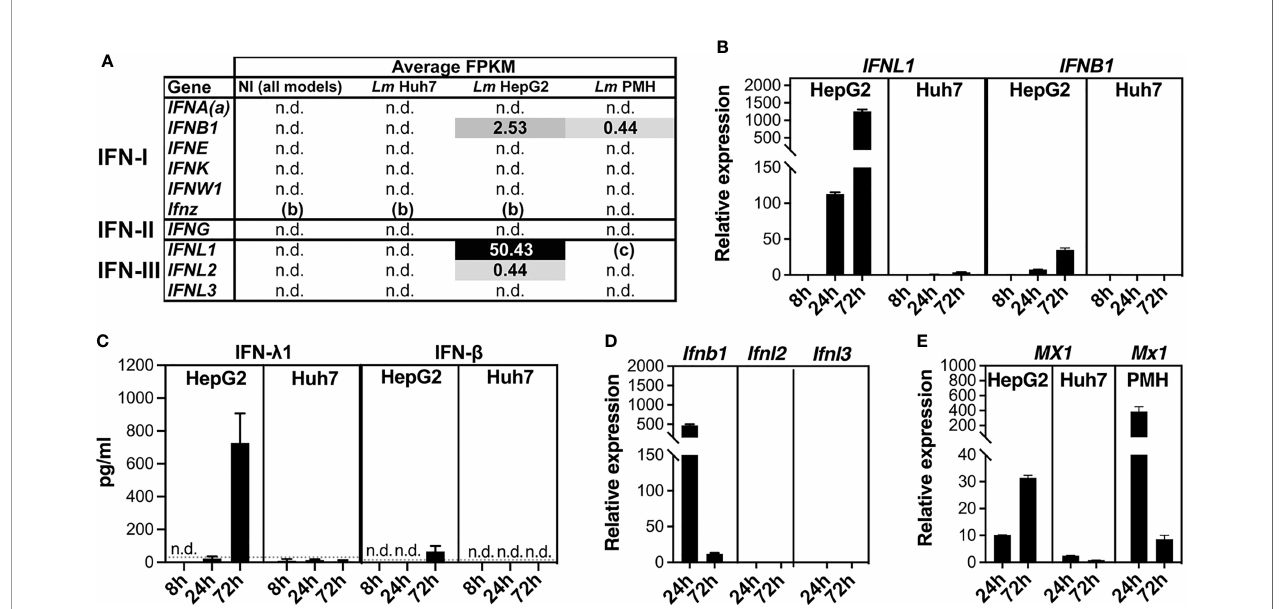
FIGURE 3 | Listeria infection triggers interferon responses in HepG2 and PMH, but not in Huh7 cells. (A) IFN gene expression in non-infected (NI) and infected ( Lm EGDe or 10403S) HepG2, Huh7 and PMH cells at 72 h p.i., assessed by mean FPKM for each type I, II, or III IFN gene. (a) IFNA represents all genes coding for IFN- a subtypes; (b) Ifnz is present in the mouse but not the human genome; (c) Ifnl1 is a pseudogene in the mouse genome. “ n.d. ” , non detectable (FPKM < 0.3, the background level). (B) RT-qPCR analysis of IFNL1 and IFNB1 transcript levels in EGDe-infected HepG2 and Huh7 cells at 8 h, 24 h, and 72 h p.i., relative to NI cells, and normalized to YWHAZ and PPIA for HepG2 and Huh7, respectively. (C) ELISA quanti fi cation of IFN- l 1 (left) and IFN- b (right) protein secreted by EGDe-infected HepG2 or Huh7 cells. Conditioned media from EGDe-infected or NI cells was sampled at 8 h, 24 h, and 72 h p.i. Dotted grey lines: limit of quanti fi cation; “ n.d. ” : below the limit of detection (LoD). All NI cell conditioned media sampled concurrently with infected samples were below the LoD (not shown). (D) RT-qPCR analysis of Ifnb, Ifnl2 and Ifnl3 transcript levels in 10403S-infected PMH at 24 h and 72 h p.i., expressed relative to NI cells, and normalized to Pdk3 and Pdk1 for 24 h and 72 h time points, respectively. (E) RT-qPCR analysis of MX1 transcript levels in EGDe-infected HepG2 or Huh7 cells, and Mx1 in 10403S-infected PMH, at 24 h and 72 h p.i., relative to NI cells, and normalized to YWHAZ , PPIA , and Pdk3/Pdk1 for HepG2, Huh7, and PMH respectively. Values represent mean ± SD